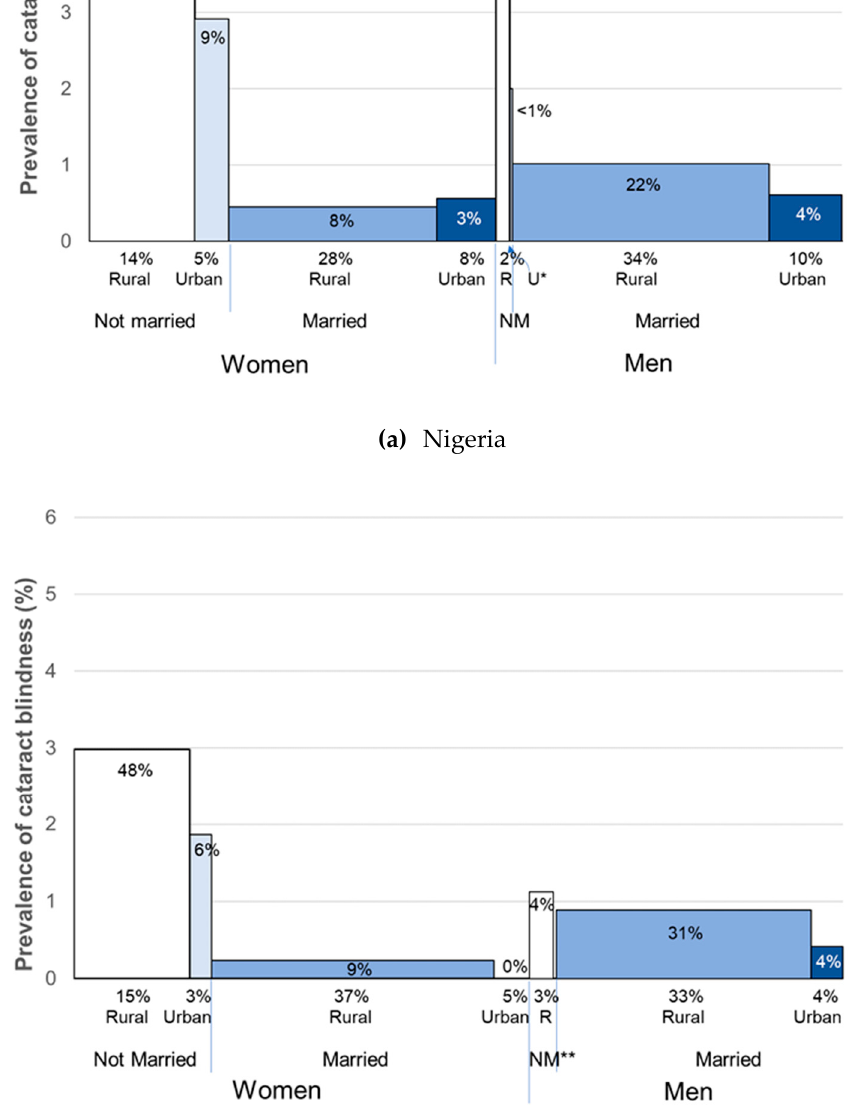
Figure 2. Prevalence of cataract blindness across social subgroups of women and men aged ≥ 40 years in ( a ) Nigeria (2005–2007) and ( b ) Sri Lanka (2012–2014). For each subgroup, the prevalence of cataract blindness is plotted along the y axis, and the proportion of the sample in each subgroup is indicated under the x -axis. For example, in Nigeria 14% of the sample were rural not-married women. The number above each bar indicates the proportion of all cataract blindness in the subgroup, for example, in Nigeria 48% of the cataract blind were rural not-married women. R = rural, U = urban, NM = not- married, * = very few urban not-married men in Nigeria, ** = zero urban not-married men with cataract blindness in Sri Lanka.